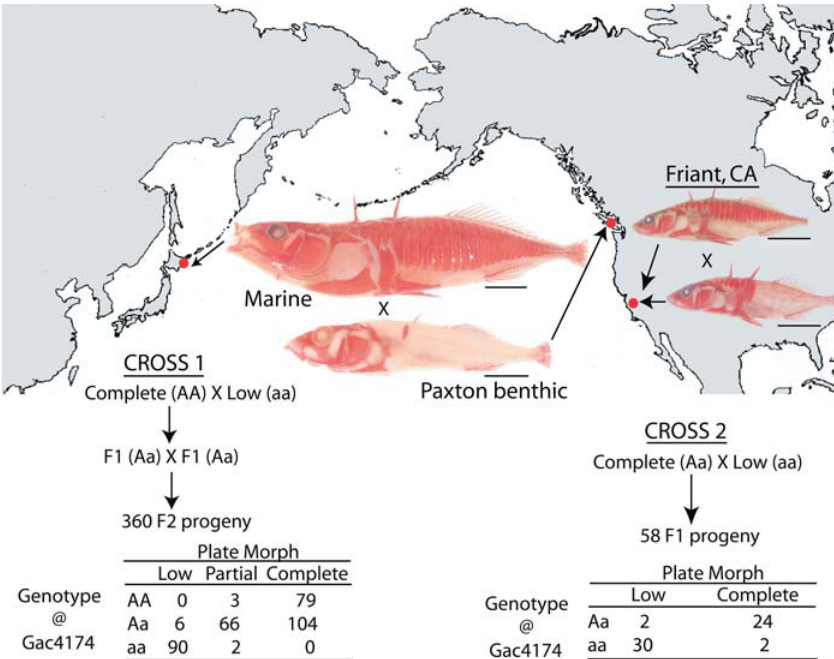
Figure 1. Mapping the Genetic Basis of Lateral Plate Reduction in Different Natural Populations of Threespine